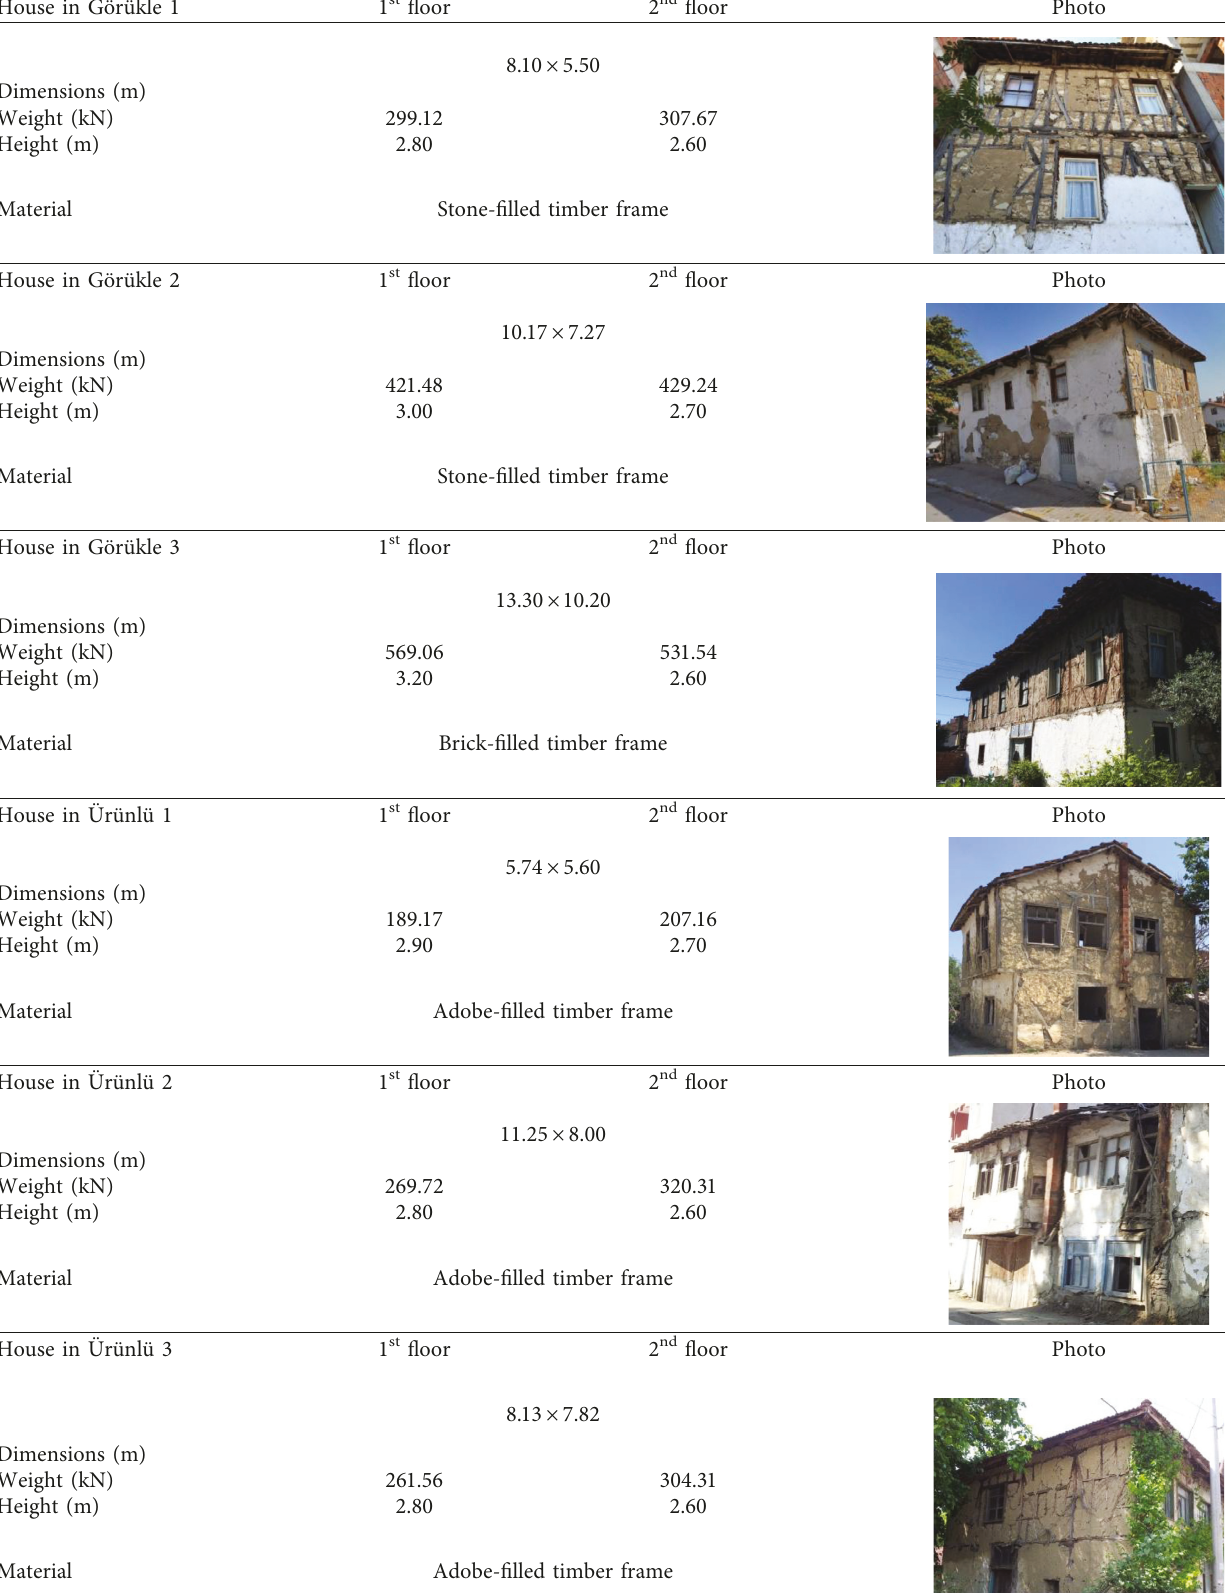
Table 1: The geometrical and architectural features of studied